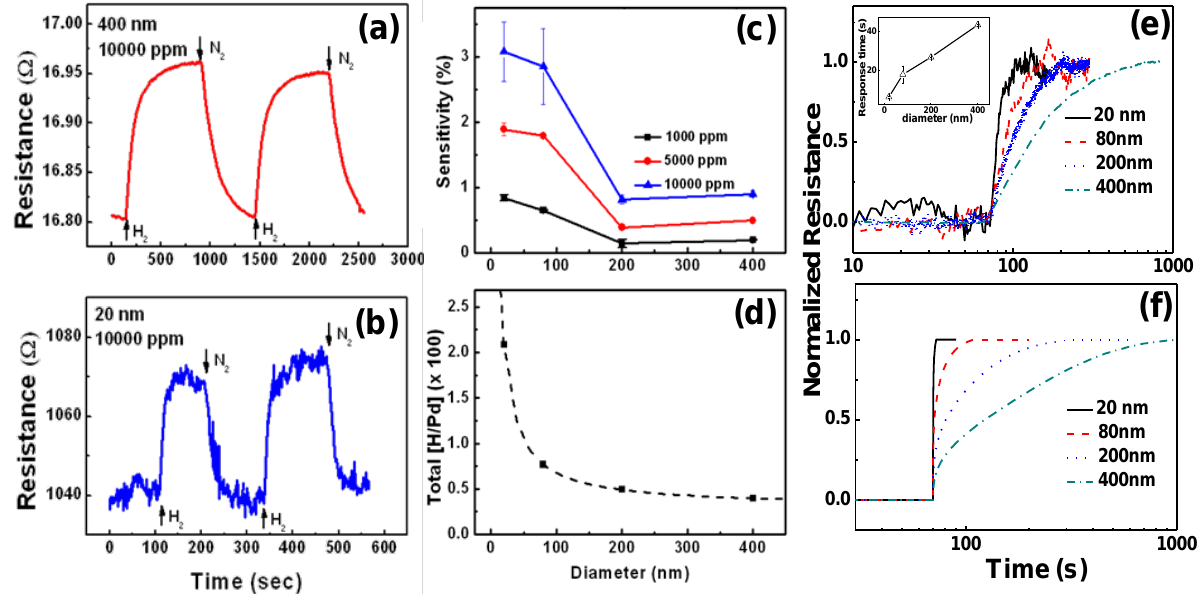
at room temperature. (c) 2